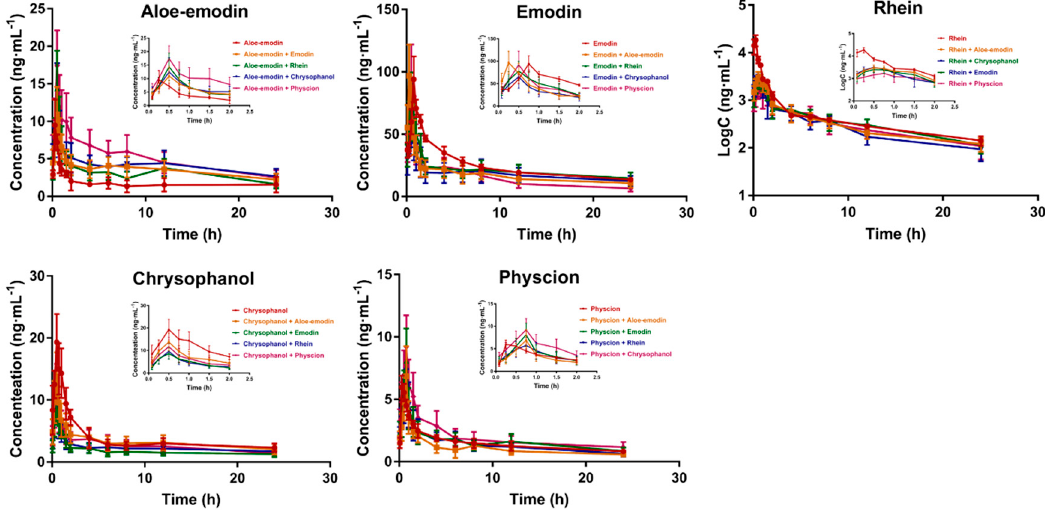
Figure 2. Mean plasma concentration–time curves.